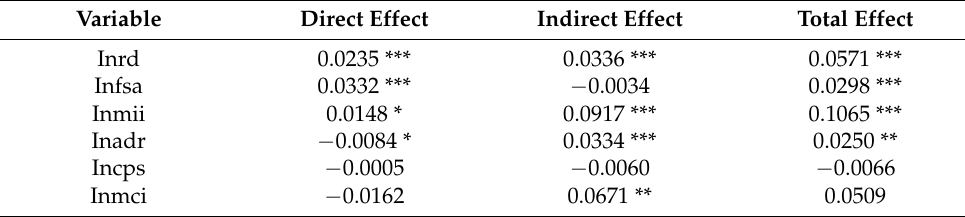
Table 15. Decomposition results of the spatial effect of the full-time equivalent of R&D personnel on agricultural green development under the economic